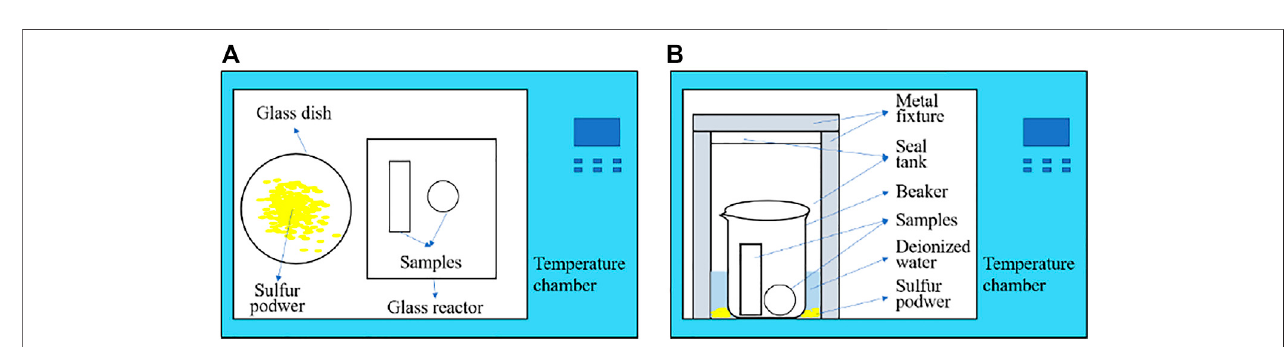
FIGURE 2 | Accelerated ageing test setups: (A) 100 ° C + Sulfur; and (B) 100 ° C + 100%RH + Sulfur.